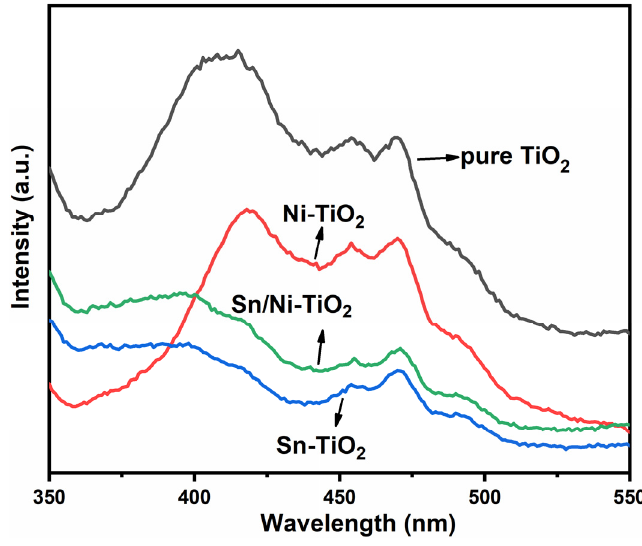
Figure 5. Photoluminescence (PL) spectra of pure TiO 2, Ni–TiO 2 , Sn–TiO 2 , and Sn/Ni–TiO 2 .